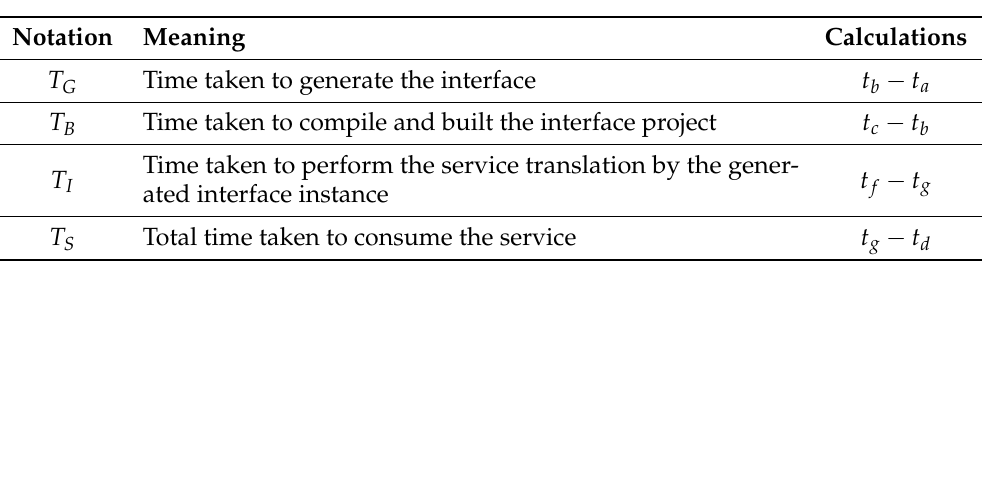
Table 4. Metrics used for the